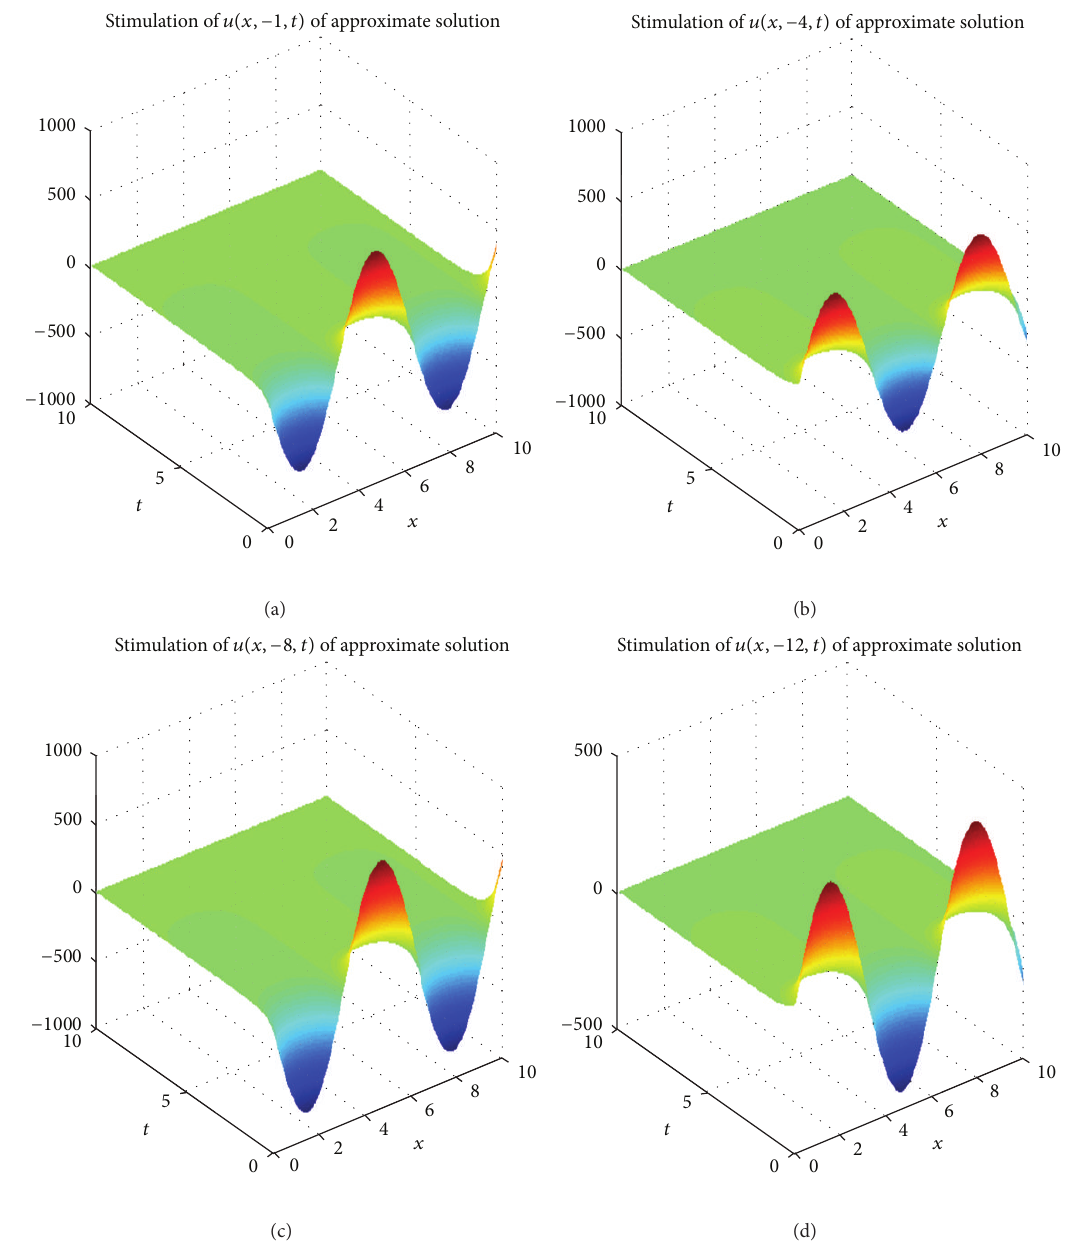
Figure 1: Numerical simulations of the approximate solution of (42) for a fixed 𝑦